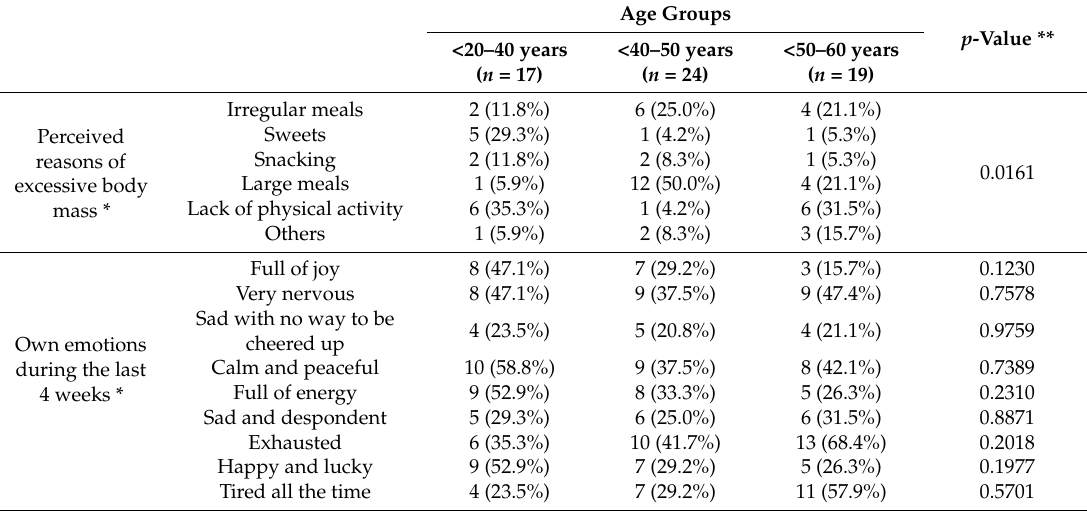
Table 5. The body mass beliefs, attitudes, and emotions of the studied group for the sub-groups stratified by